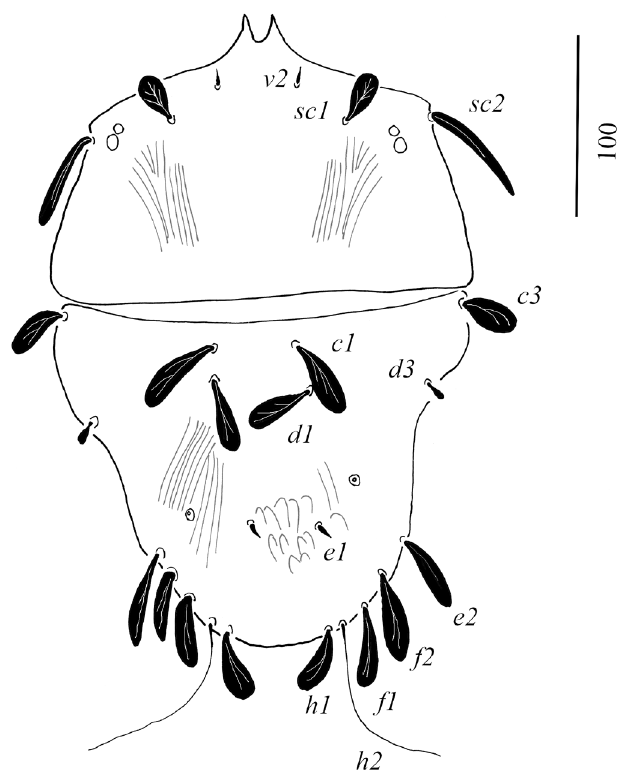
Figure 29. Dorsal view of Tenuipalpus szarvasensis Bozai, 1970, holotype, female. 13, 1c and 2c 24–25, ag 12, g1 – g2 14–16. Pseudanal setae, all 12–13. All ventral setae simple and